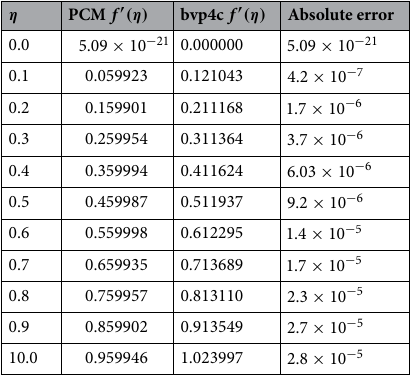
Table 4. Comparative analysis between bvp4c and PCM techniques for velocity.